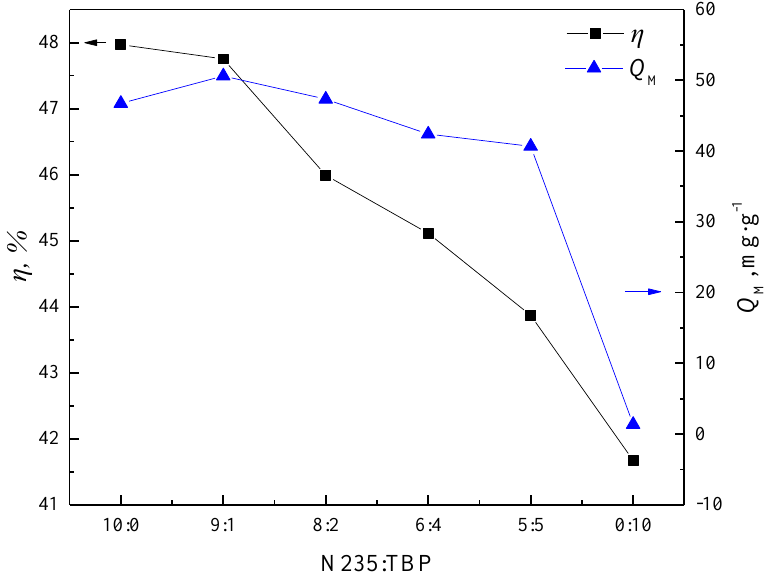
Figure 1. Effects of the molar ratio of N235 to tributyl phosphate (TBP) on the preparation of N235-TBP impregnated resins (N-TIRs) and adsorption capacity for V(V) (Extractants concentration = 1.0 mol · L − 1 ) ( C 0 (V) = 1200 mg · L − 1 , 14 h adsorption time, 25 ◦